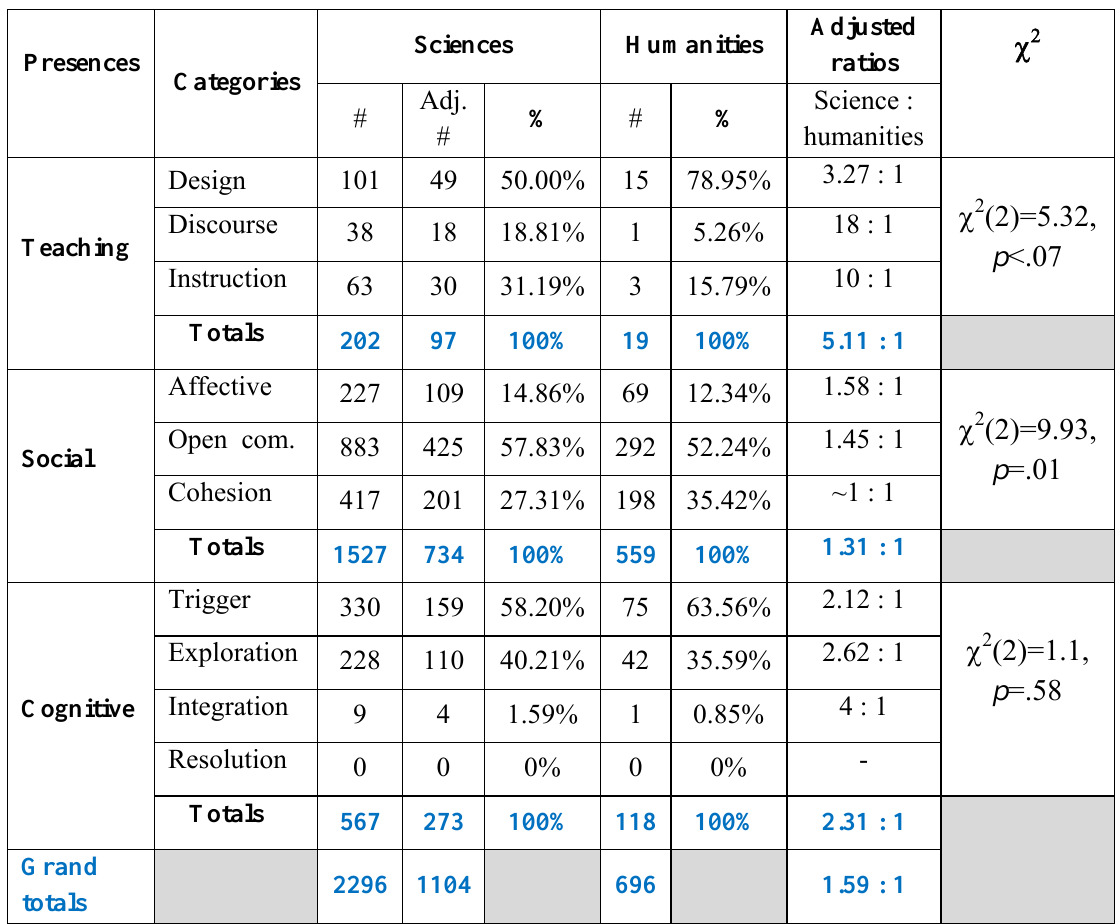
Teaching, Social, and Cognitive Presence by Categories: Students